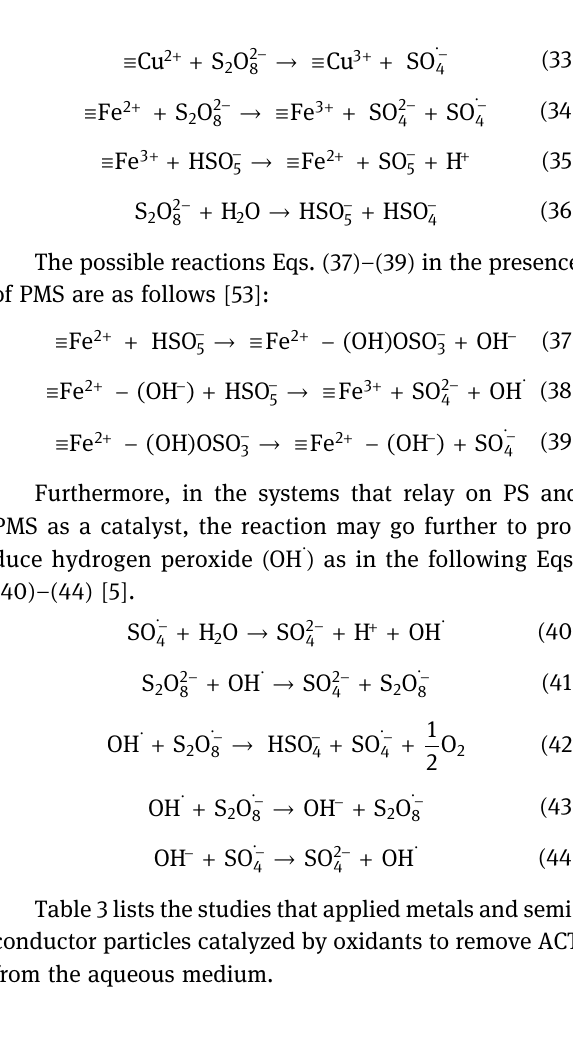
Figure 3: ( a ) Both ACT and O 3 were adsorbed on the zeolite surface, ( b ) O 3 was attacked with ACT, and ( c ) both O 3 and ACT